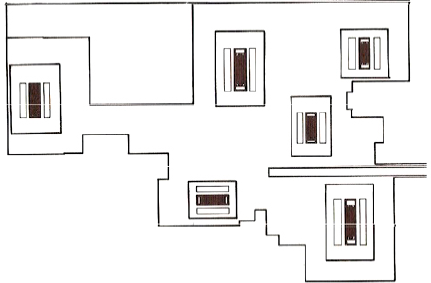
fig. 3a. an example of an advanced TPH. a general perspective of Boroojerdiha House in Kashan (Documentation and research... 1966: 35)